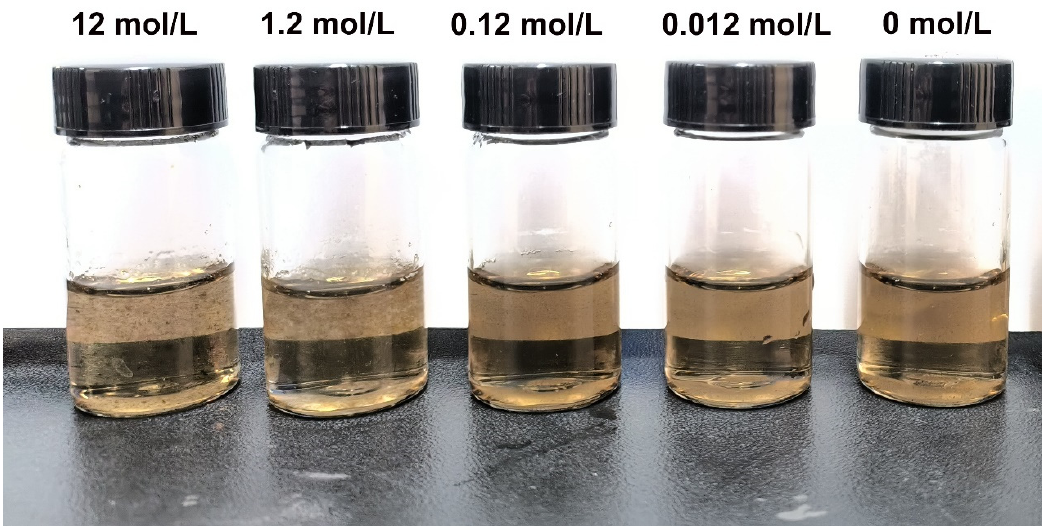
Figure 1. A macroscopic photograph of GOS treated with different concentrations of HCl (12 mol/L, 1.2 mol/L, 0.12 mol/L, 0.012 mol/L, 0 mol/L).